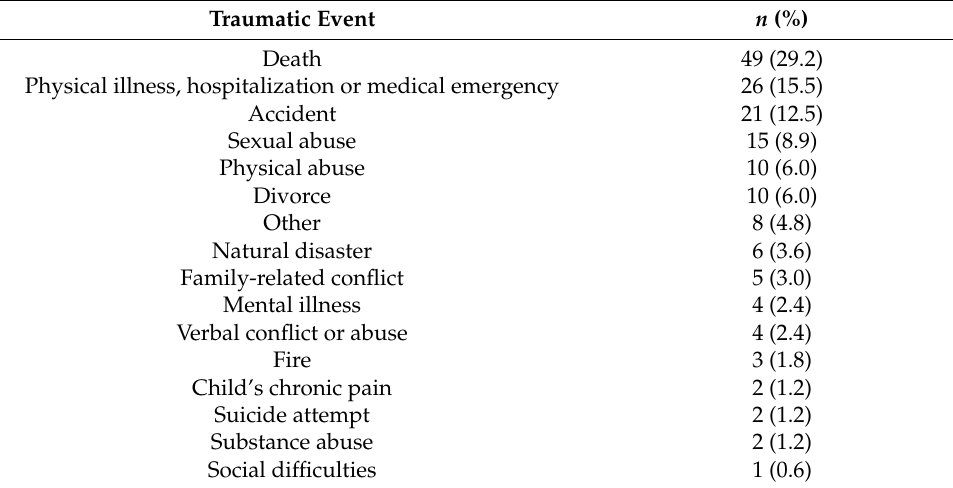
Table 2. Types of traumatic events reported by parents.